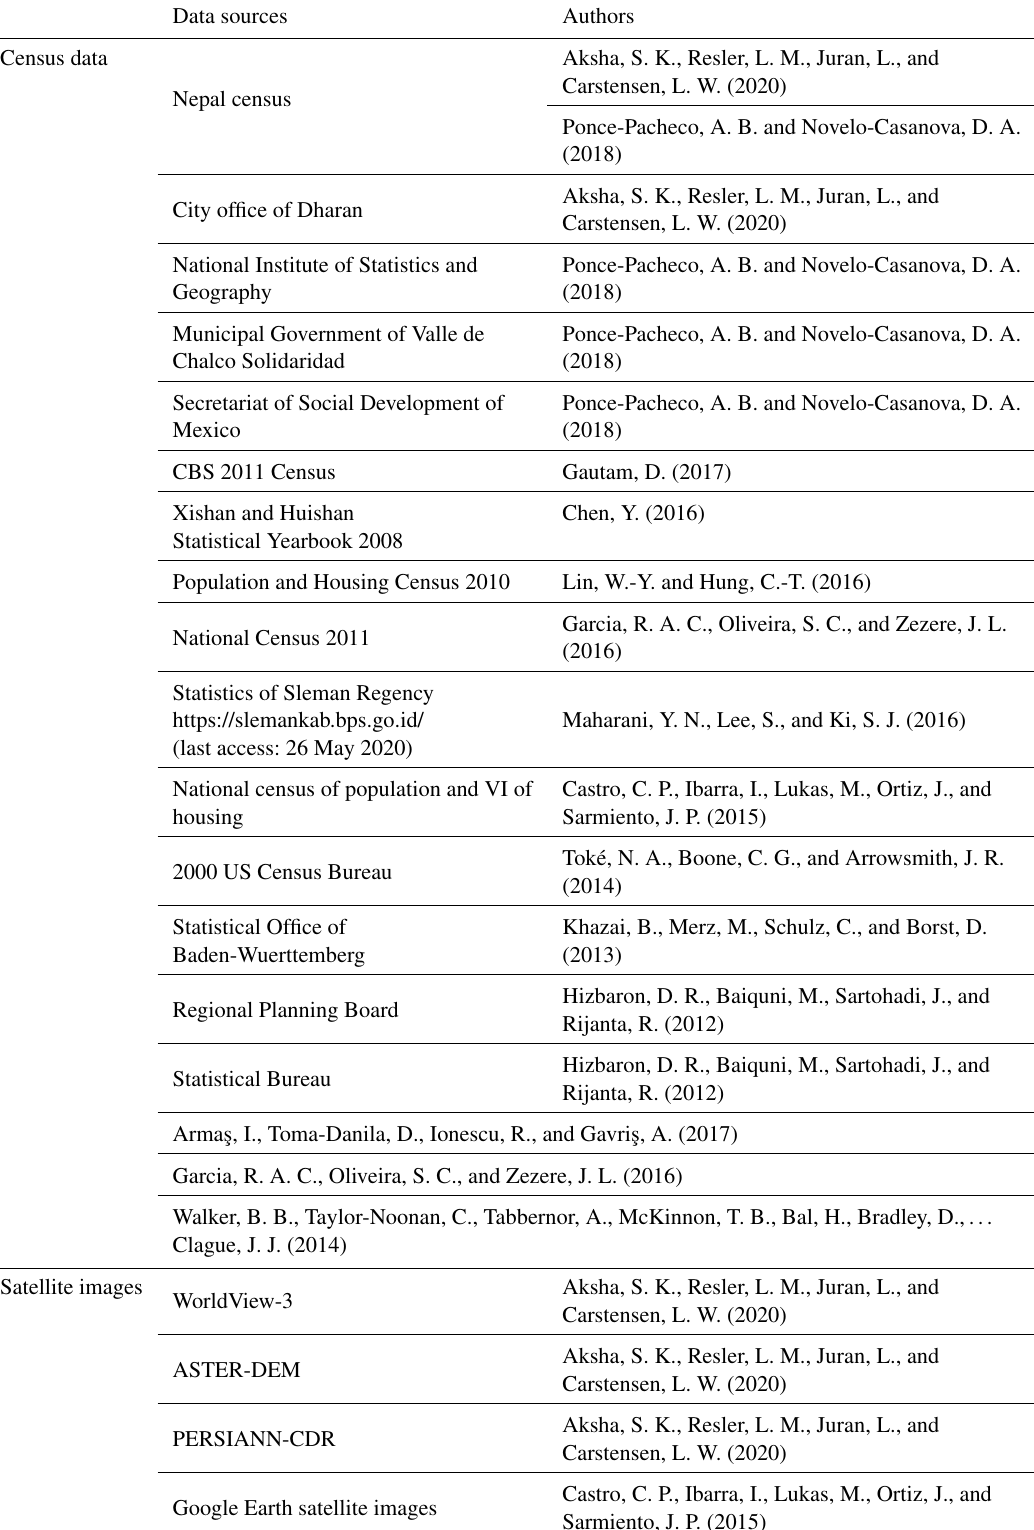
Table 3. Data sources for the spatial assessment of socio-economic vulnerability